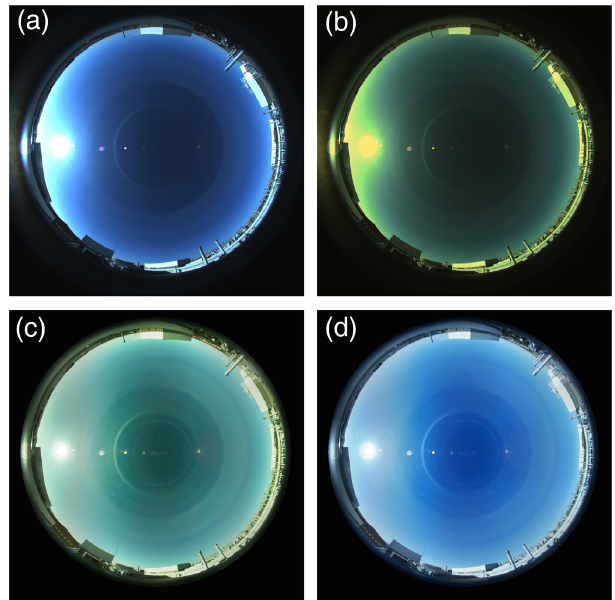
Figure 2. Colour sky images of Valladolid on 17 August 2019 at 07:25UTC of the (a) direct capture with exposure time equal to t 4 , (b) direct capture with exposure time equal to t 4 but removing the previous white balance, (c) tone map of HDR image and (d) tone map of HDR image but with white balance